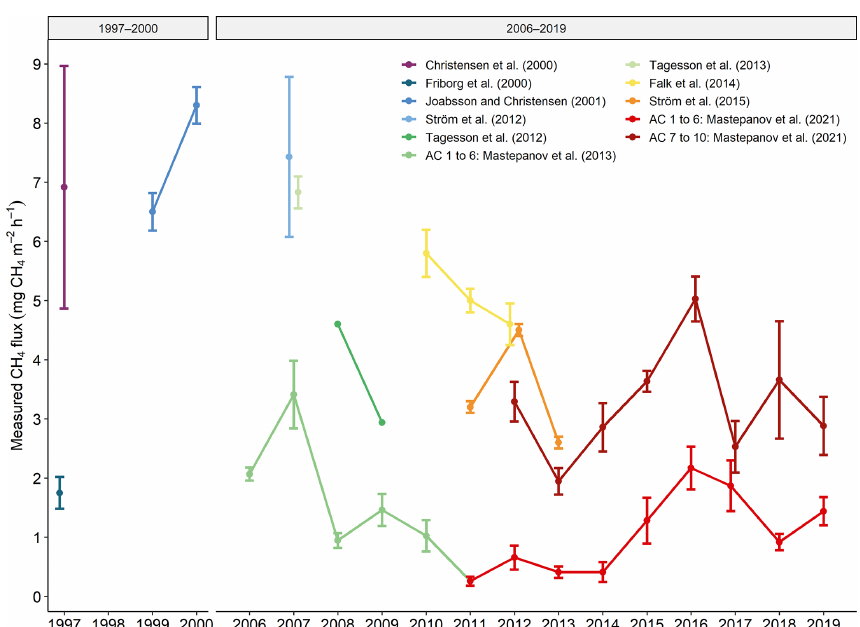
Figure 4. Timeline of methane fluxes measured during the growing season (1 July–31 August for AC) measured in fen areas (hummocky and continuous fen) and at the fringe of the fen (AC 1 to 6). Colors show different datasets. Please note that the years 2001–2005 are left out, as no published studies focusing on methane fluxes in undisturbed areas were made in this period. Also, note that points may be shifted slightly along the year axis to avoid overplotting.